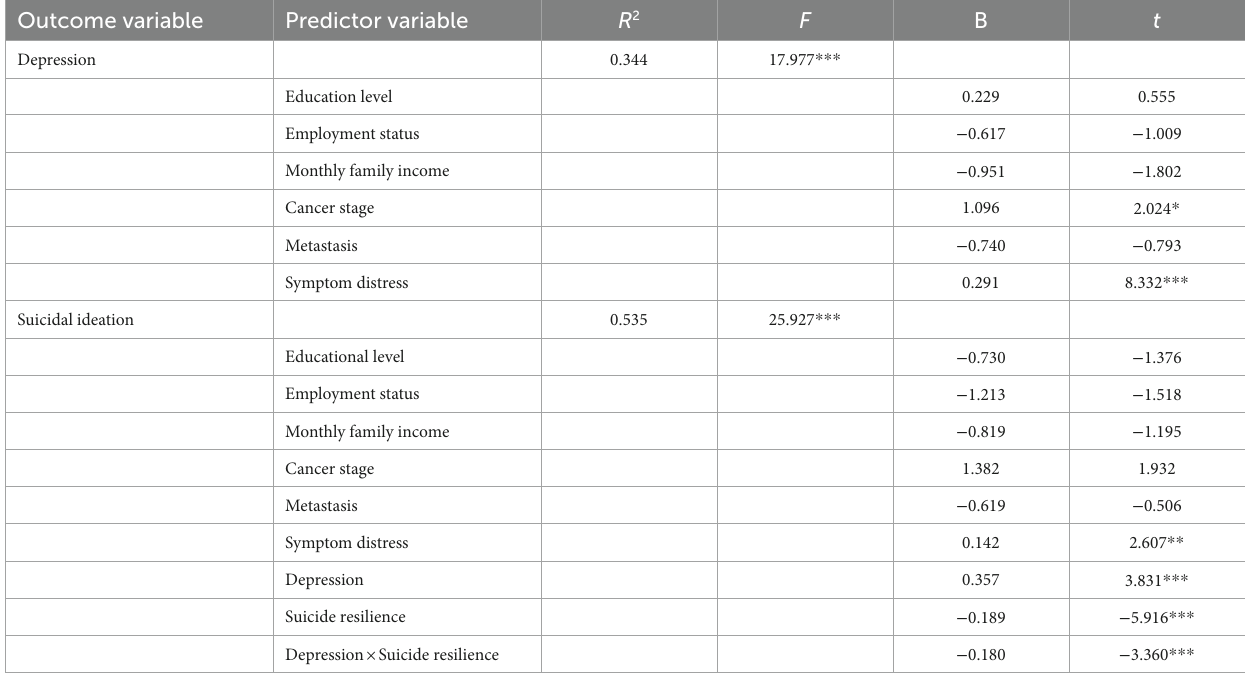
TABLE 5 The moderated mediation model with depression as a mediator and suicide resilience as a moderator.